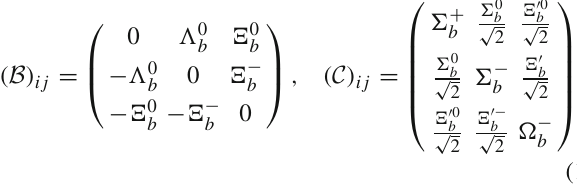
(cid:2) 0 → (cid:2) 0 Z c (right) are presented for b